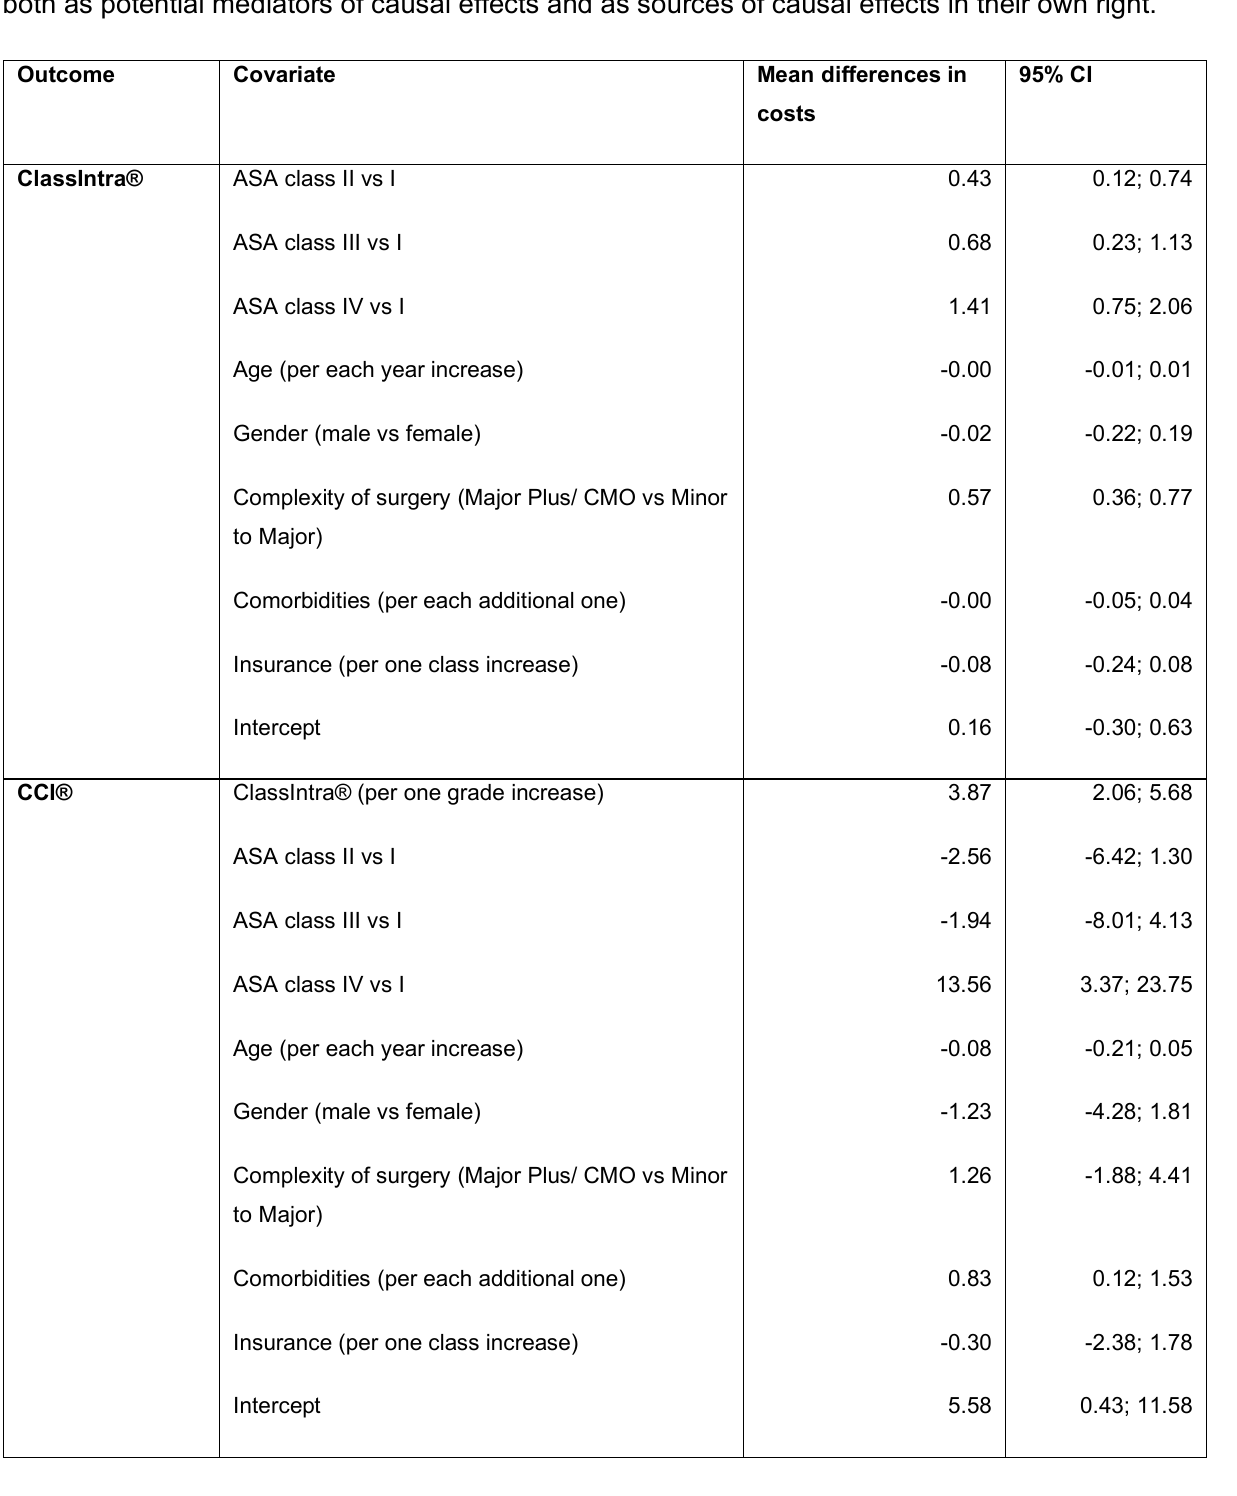
Table 2: Complete cost model with full output (in Euros) Structural equation model including all patients (n=320) showing total effects of fixed patient characteristics and hospitalisation-related parameters on total hospital costs. Patient characteristics were considered as exogenous variables while hospitalisation-related parameters were considered both as potential mediators of causal effects and as sources of causal effects in their own